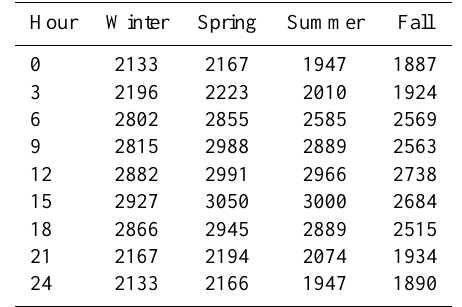
Table 1. Number of data available at different forecasting times over southern Italy from the SYNOP reports of wind speed and direction for each season. The table shows the first day. For the second day the available data show similar values (compare 0 and